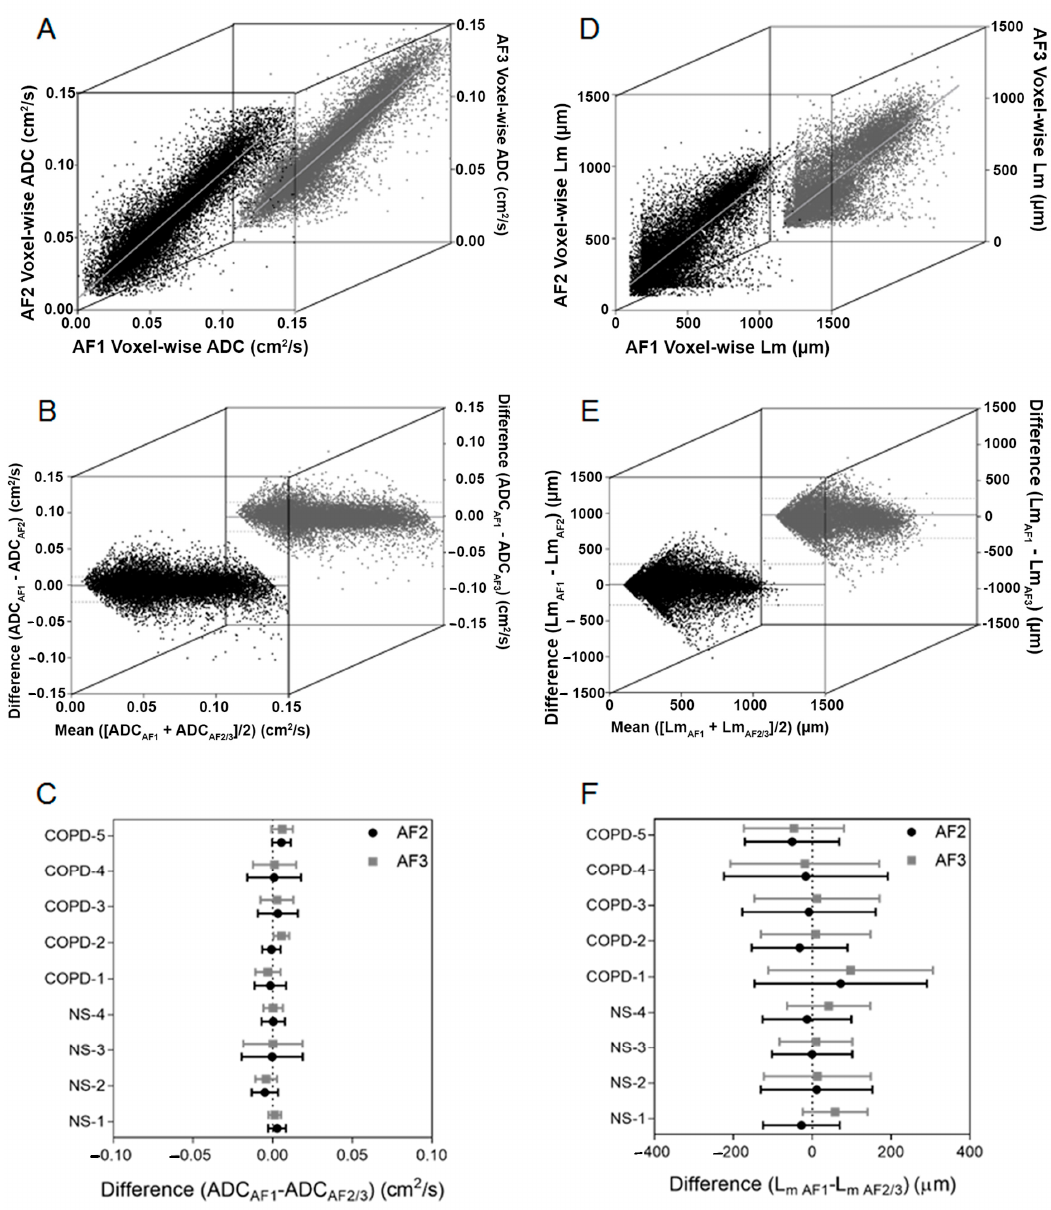
Figure 3. Relationships between ADC and L m with acceleration factor. ( A ) ADC; AF-1 was signifi- cantly correlated with AF-2 (r 2 = 0.82, ρ = 0.90, p < 0.0001, y = 0.88x + 0.008) black dots, and AF-1 was significantly correlated with ADC A-F3 (r 2 = 0.86, ρ = 0.92, p < 0.0001, y = 0.87x + 0.008) grey dots. ( B ) Bland-Altman analysis of agreement for ADC AF-1 with AF-2 (bias = − 0.0002 ± 0.01 cm 2 /s, lower limit = − 0.02 cm 2 /s, upper limit = 0.02 cm 2 /s) black dots and Bland-Altman analysis of agreement for ADC AF-1 with AF-3 (bias = − 0.0007 ± 0.01 cm 2 /s, lower limit = − 0.02 cm 2 /s, upper limit = 0.02 cm 2 /s) grey dots. ( C ) ADC differences for AF-1 with AF-2 (black) and AF-3 (gray) for each participant. ( D ) L m ; AF-1 was significantly correlated with AF-2 (r 2 = 0.64, ρ = 0.75, p < 0.0001, y = 0.79x + 101) black dots. AF-1 was significantly correlated with AF-3 (r 2 = 0.66, ρ = 0.76, p < 0.0001, y = 0.77x + 78) grey dots. ( E ) Bland-Altman analysis of agreement for L m AF-1 with AF-2 (bias = 8 ± 146 µ m, lower limit = − 278 µ m, upper limit = 293 µ m) in black. Bland- Altman analysis of agreement for L m AF-1 with AF-3 (bias = − 24 ± 141 µ m, lower limit = − 300 µ m, upper limit = 252 µ m) in grey. ( F ) L m differences for AF-1 and AF-2 (black) and AF-3 (gray) for each participant. Dotted lines indicate the 95% confidence